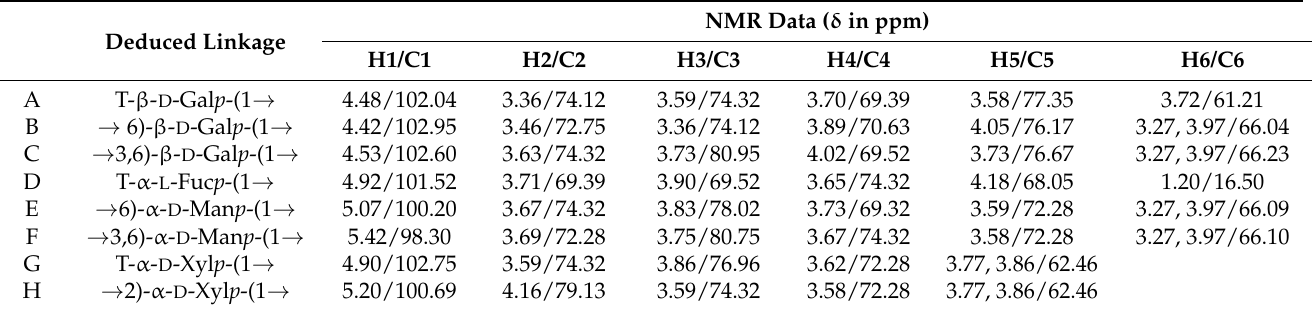
Table 3. 1 H and 13 C NMR Chemical Shifts of PAP-3 from P. aquilinum .